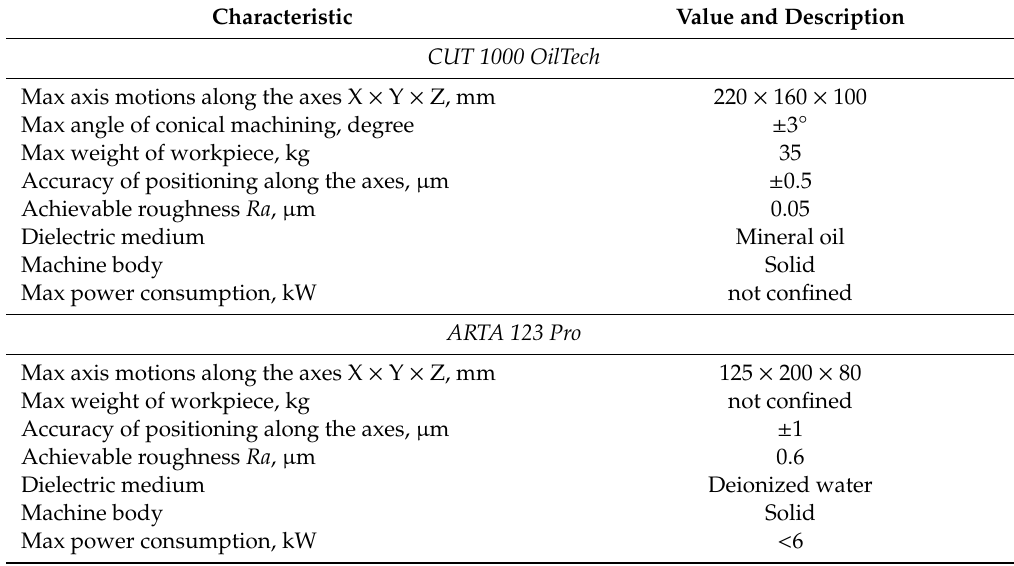
Table 2. Main characteristics of wire electrical discharge machines used in experiments.